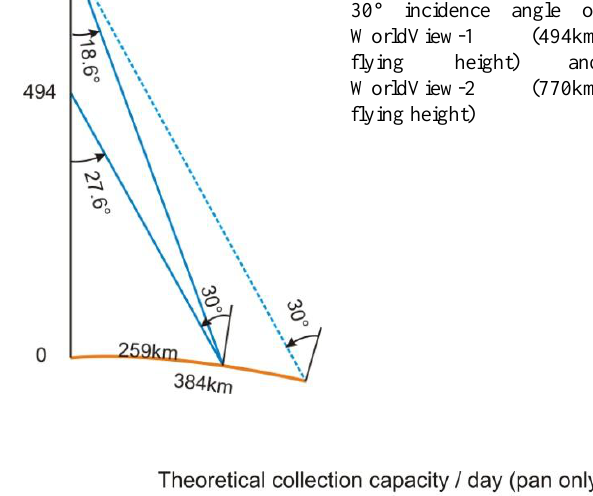
Figure 6. field of regard for